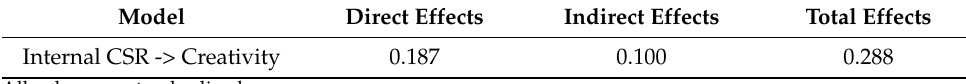
Table 4. Direct, indirect, and total effects of the final research